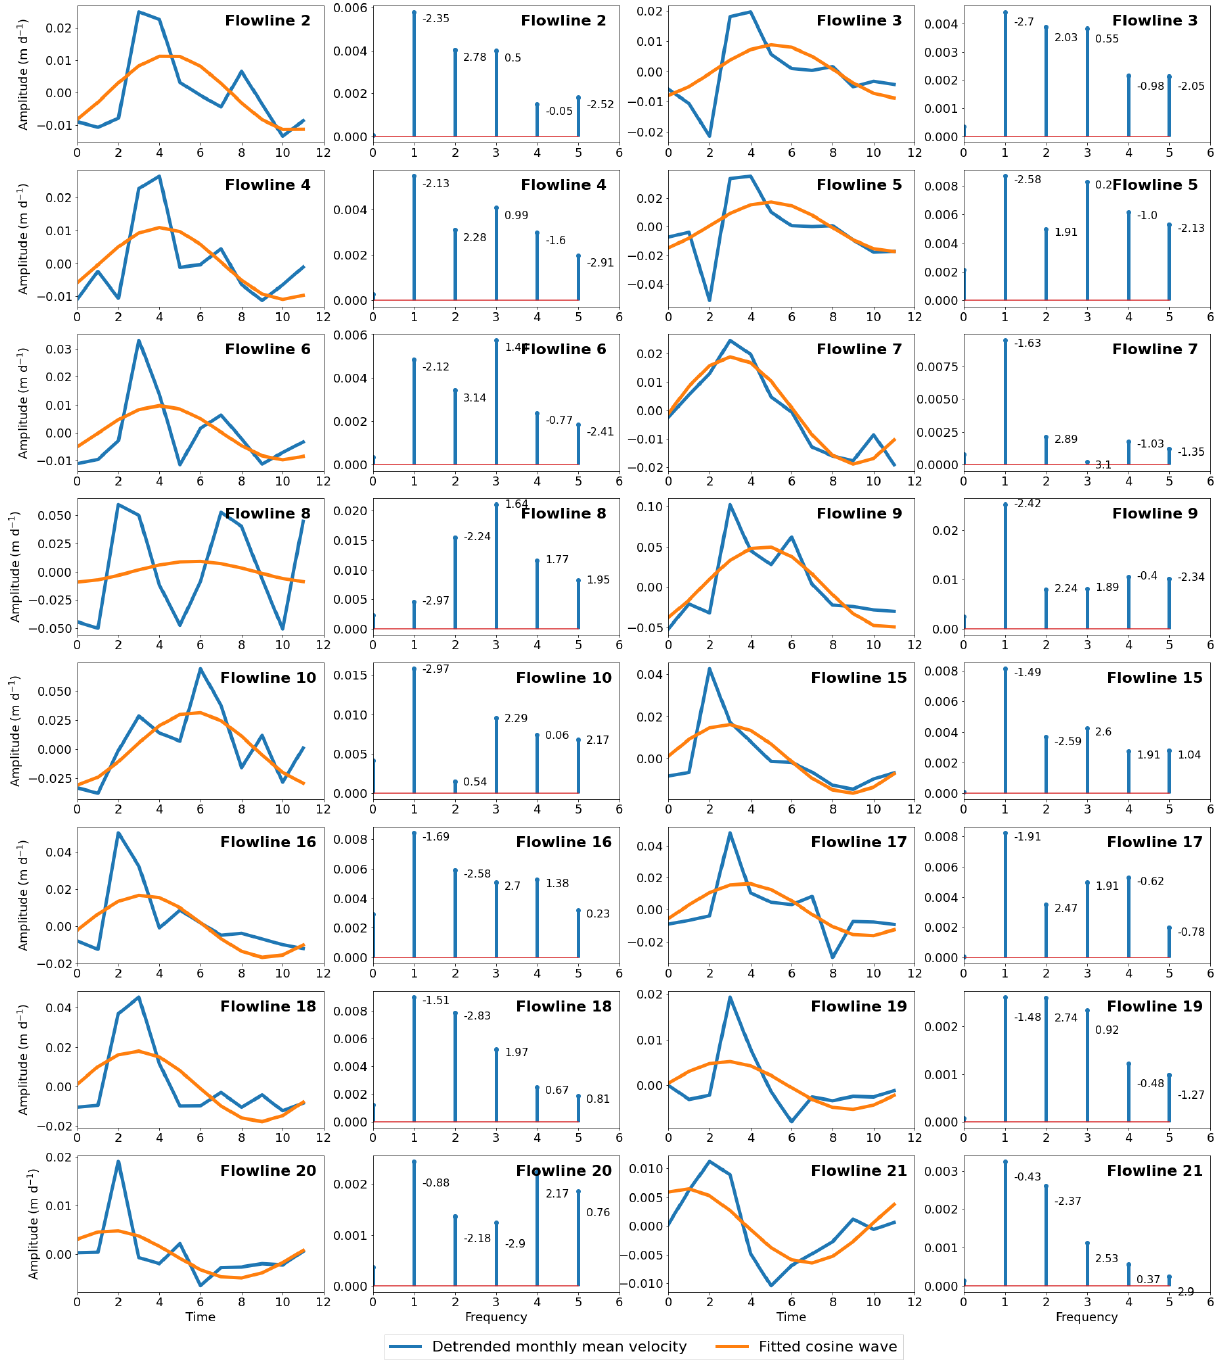
Figure D1. Discrete Fourier transform outputs. Left-hand panels indicate the time domain where time 0 denotes 1 October. Panels show mean monthly ice flow of each outlet glacier (blue; same as Fig. 5) with fitted cosine functions (orange) optimised to the most dominant frequency observed across all outlet glacier time series. Right-hand panels indicate the frequency domain, whereby the greatest amplitude associated with each glacier time series denotes the most dominant frequency. In the context of the present study, a dominant frequency of 1 denotes one complete seasonal cycle per year. Annotated values indicate the phase associated with each frequency